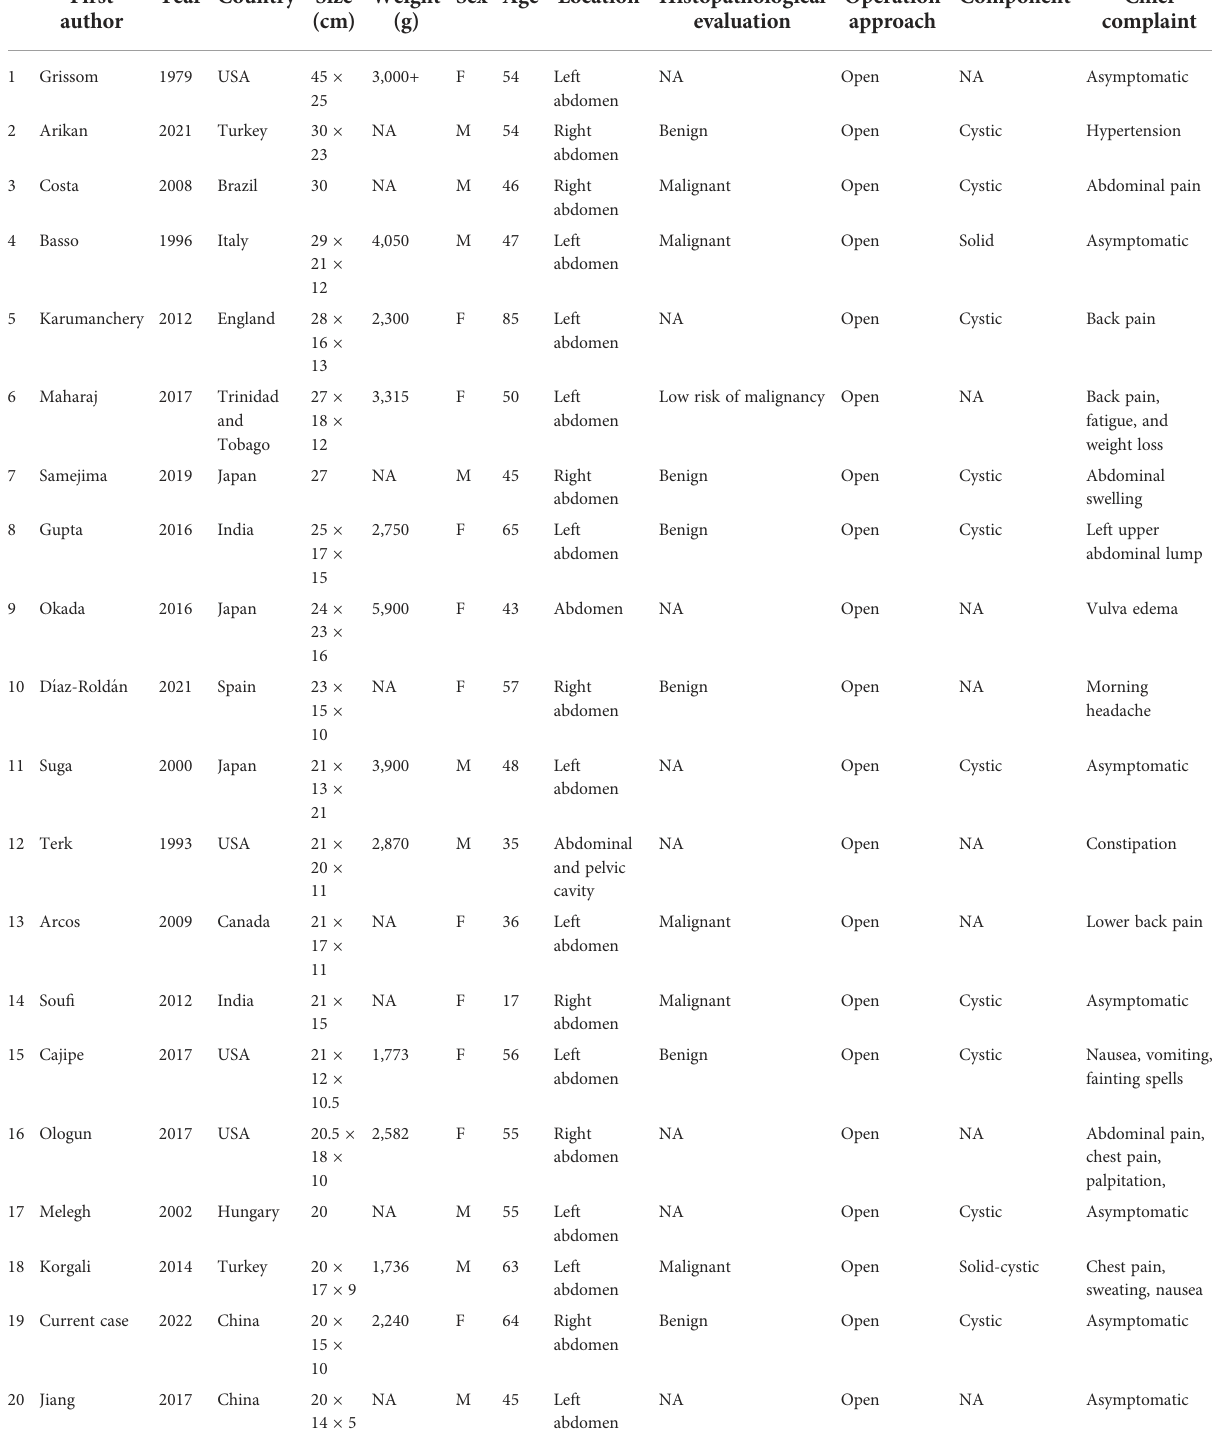
TABLE 2 A summary of reported giant pheochromocytomas with a maximal diameter greater than 20 cm, arranged by the largest to smallest maximum